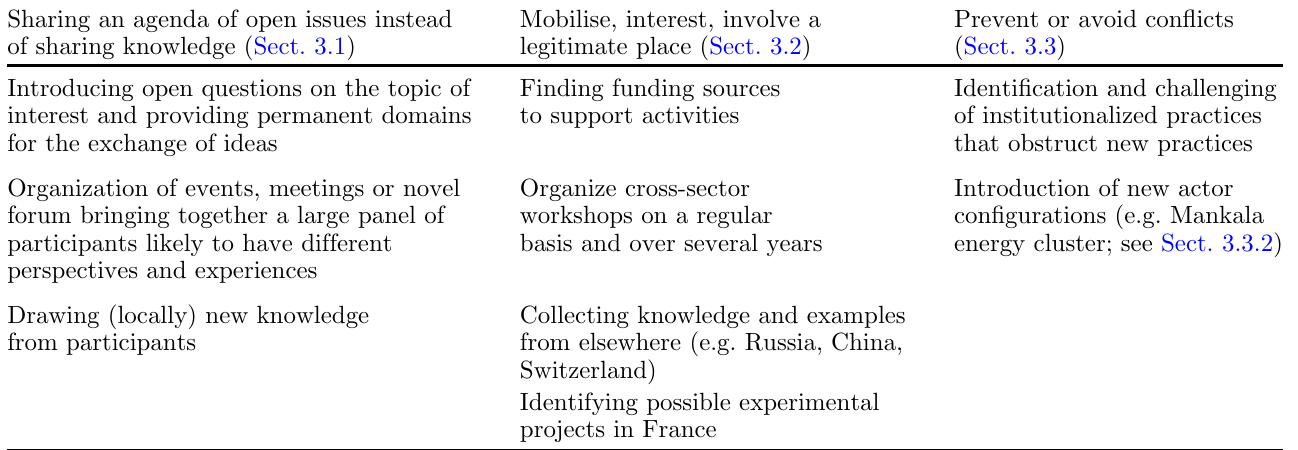
Table 2. Actions that could be led by intermediaries to nurture niche experiment. Sharing an agenda of open issues instead of sharing knowledge (Sect.